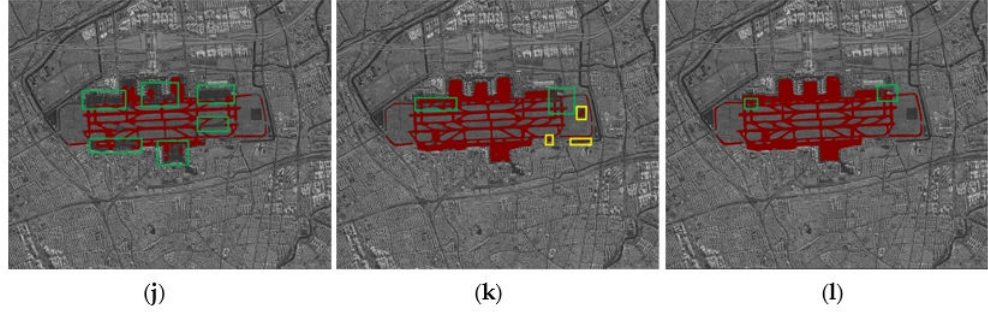
Figure 12. The experiment result for Airport IV. ( a ) SAR image of Airport IV from Gaofen-3. ( b ) The down-sampled SAR image of ( a ) by 5 times. ( c ) The ground truth of the airport for ( b ). ( d ) The extraction result of ( b ) by RefineNet. ( e ) The extraction result of ( b ) by DeepLabV3. ( f ) The extraction result of ( b ) by MDDA. ( g ) The fusion map of ( d , b ). ( h ) The fusion map of ( e , b ). ( i ) The fusion map of ( f , b ). ( j ) The fusion map of ( a , d ) up-sampled by 5 times. ( k ) The fusion map of ( a , e ) up-sampled by 5 times. ( l ) The fusion map of ( a , f ) up-sampled by 5 times.